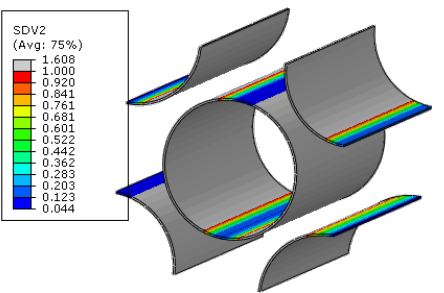
Figure 19. Failure indices and traction force states for the interface. ( a ) failure indices; ( b ) normal traction; ( c ) longitudinal shear traction; ( d ) tangential shear traction.